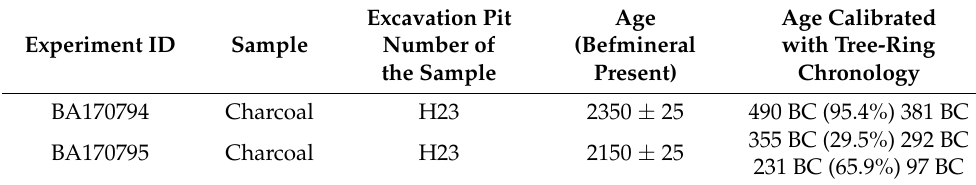
Table 2. Radiocarbon dating results of charcoal samples from the Yubeidi site.